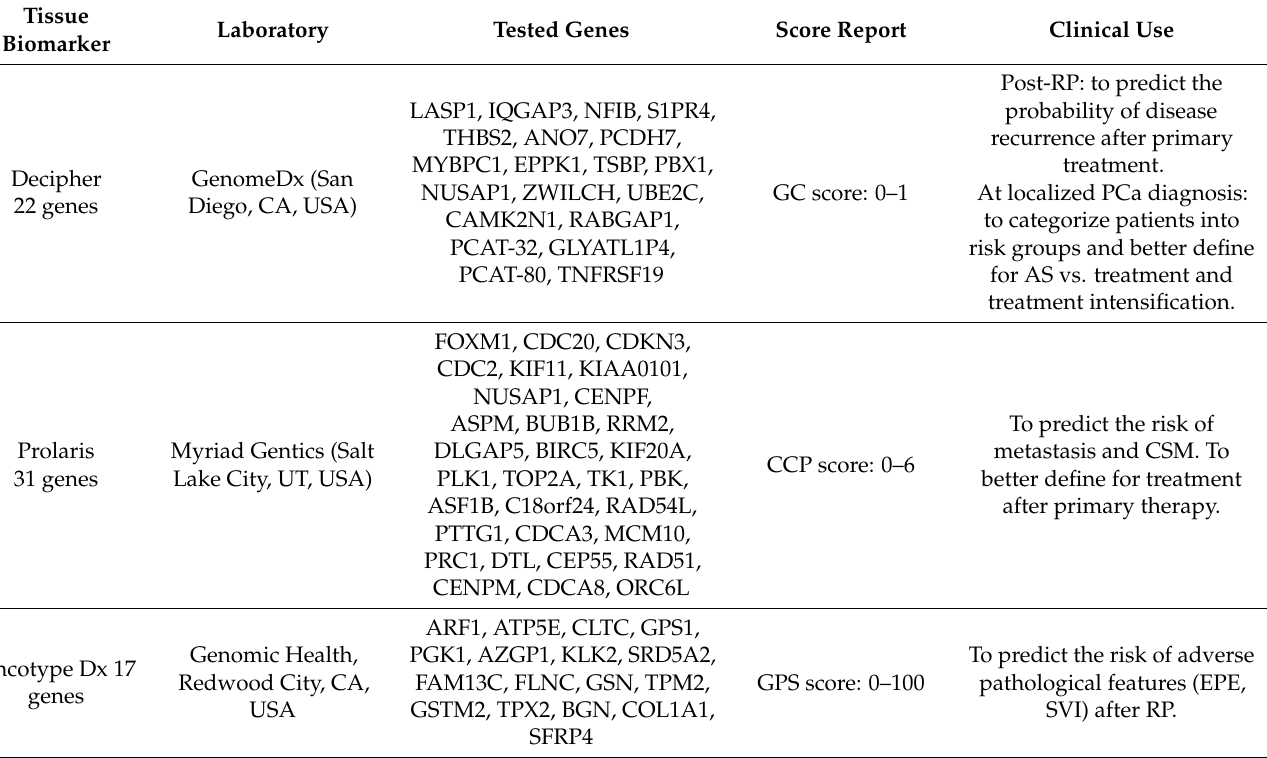
Table 1. Tissue-based mRNA genomic